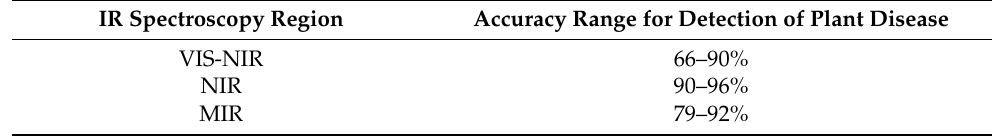
Table 4. Accuracy range for detection of plant disease in different IR spectroscopy